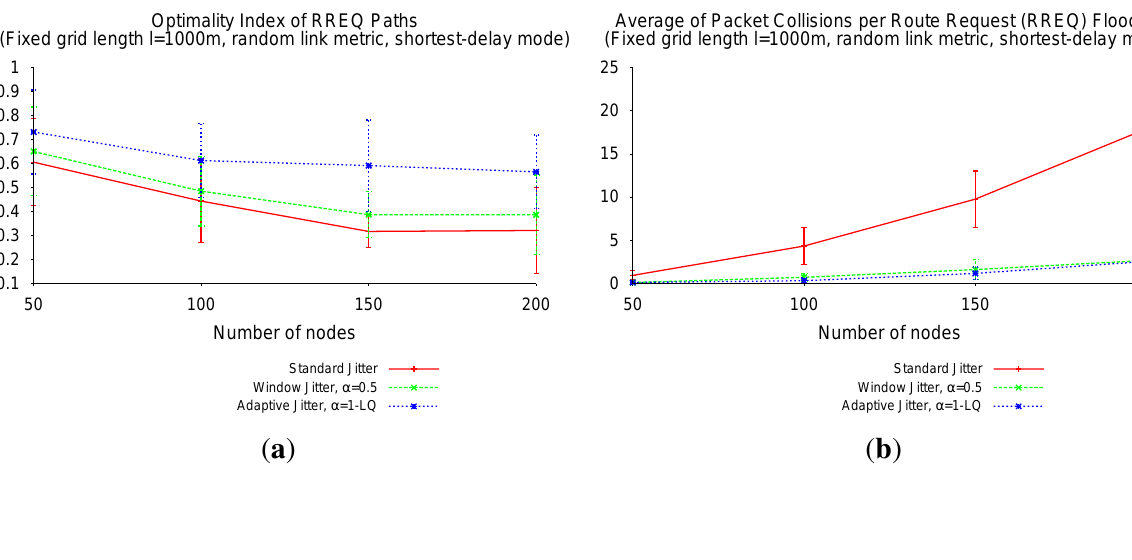
Figure 11. Shortest-delay RREQ flooding. ( a ) Optimality index; ( b ) RREP (route reply) packet